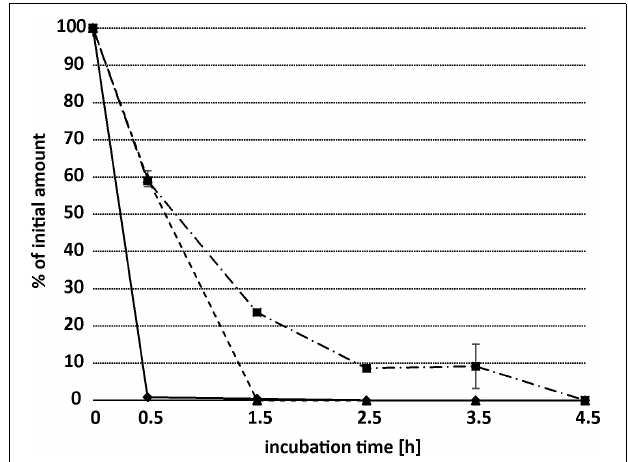
FIGURE 6 | Time-dependent depletion of biphenyl (diamonds, solid line), flavone (triangles, dashed line), and flavanone (squares, dash-and-dot line) by the whole-cell extract of E. coli expressing BPDO_AVS. The depletion of substrates was determined using the crude extract of E. coli IPTG-induced cells bearing pQE31-bphAE_AVS and pYH31-bphFGBC_LB400, incubated with a 20 µ M substrate. Error bars represent standard deviation ( n =